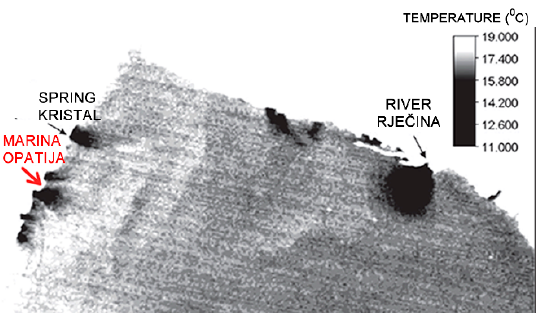
Figure 7. Position of springs according to the spatial distribution of temperature difference on 12 June 2002 [27].